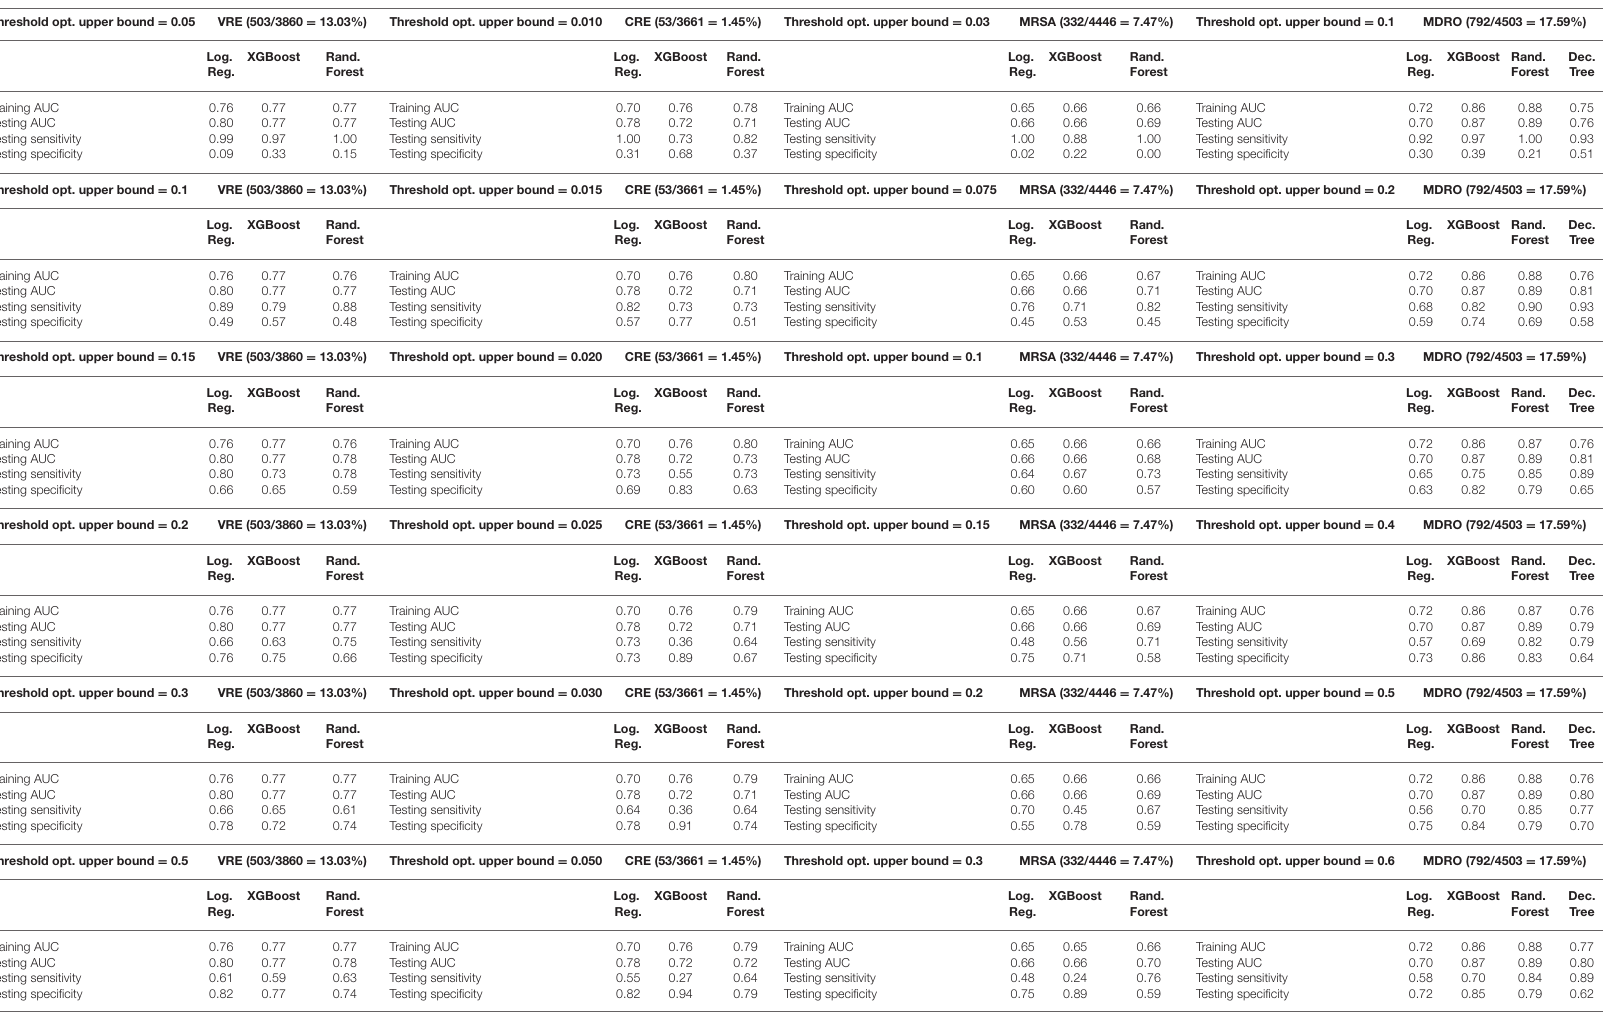
TABLE 4 | Performance summary of the machine learning models for VRE, CRE, MRSA, and MDRO colonization predictions. Thresholdopt.upperbound = 0.05 VRE(503/3860 = 13.03%) Thresholdopt.upperbound = 0.010 CRE(53/3661 = 1.45%) Thresholdopt.upperbound =